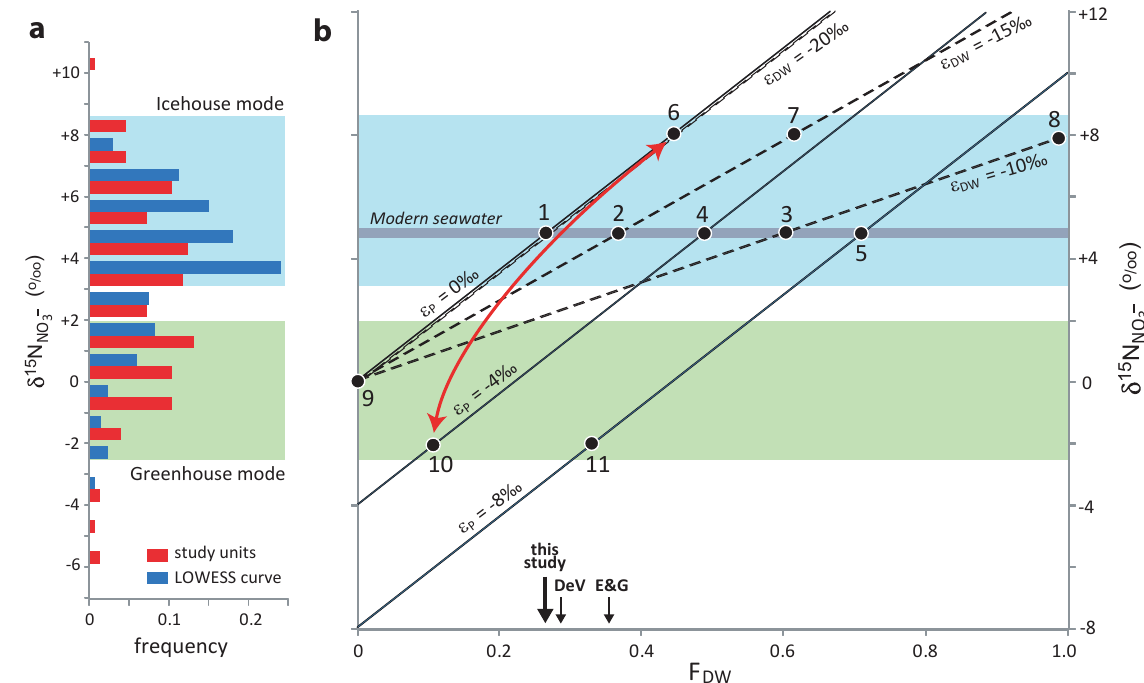
Fig. 8. δ 15 N distributions and modeling constraints. (a) Frequency distributions for unit-median δ 15 N sed values (red) and LOWESS curve values (blue). Note that both distributions exhibit bimodal character, with modes at ∼− 2 to + 2‰ and ∼+ 4 to + 8‰ representative of greenhouse and icehouse climate modes, respectively. (b) Reservoir box model estimates of δ 15 N column denitrification ( F DW ) . The dashed diagonal lines represent variable fractionation during water-column denitrification ( ε DW ) , and the solid diagonal lines variable fractionation during photosynthetic uptake of seawater fixed N ( ε P ) . Colored fields show the isotopic range of marine δ 15 N sed during greenhouse (green) and icehouse (blue) climate modes as well as modern seawater δ 15 N 2000). Arrows at bottom show F DW of 0.27 (this study), 0.29 (DeVries et al., 2012), and 0.36 (Eugster and Gruber, 2012). The red curve represents our “most likely scenario” of concurrent changes in F DW and ε P asa function of greenhouse-icehouse climate shifts. See text for discussion of numbered